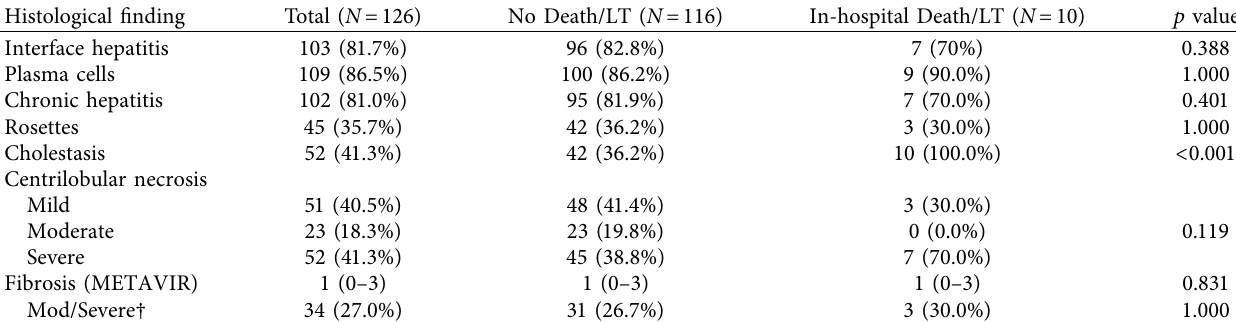
Table 3: Histological findings from liver biopsies of acute autoimmune hepatitis patients.